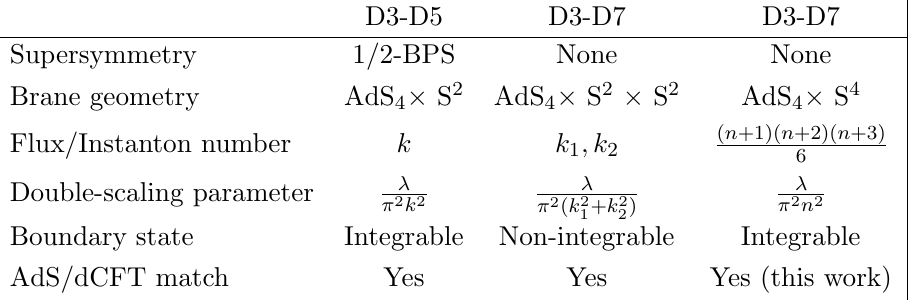
Table 1 . The string theory con(cid:12)gurations dual to the dCFT versions of N = 4 SYM theory with non-vanishing vevs. The discussion of the integrability properties of the corresponding boundary states can be found in [19, 20] and the test of the match between gauge theory and string theory referred to in the (cid:12)rst two columns can be found in